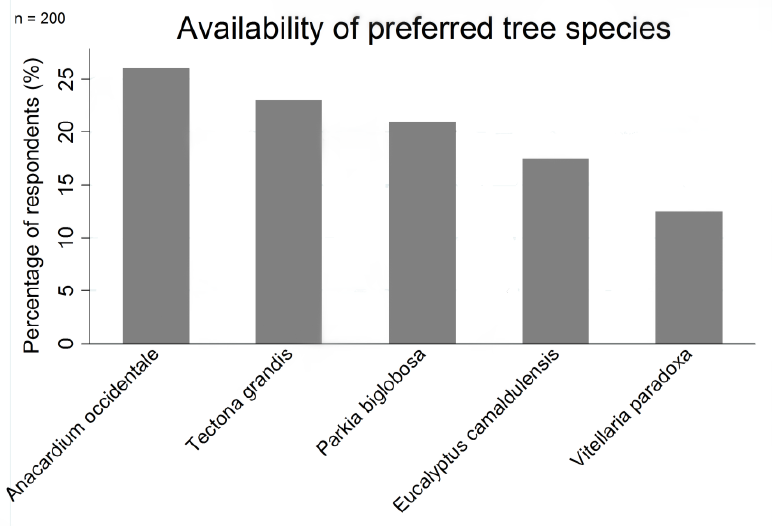
Figure 3. Percentage of respondents citing preferred